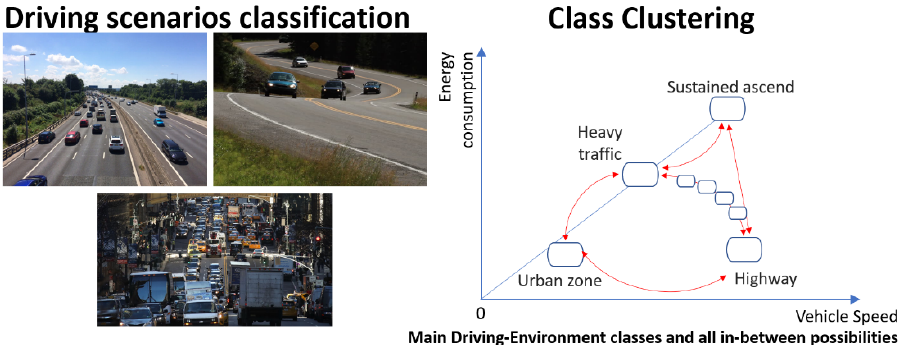
Figure 15. Application and future development of driving environment classification systems.